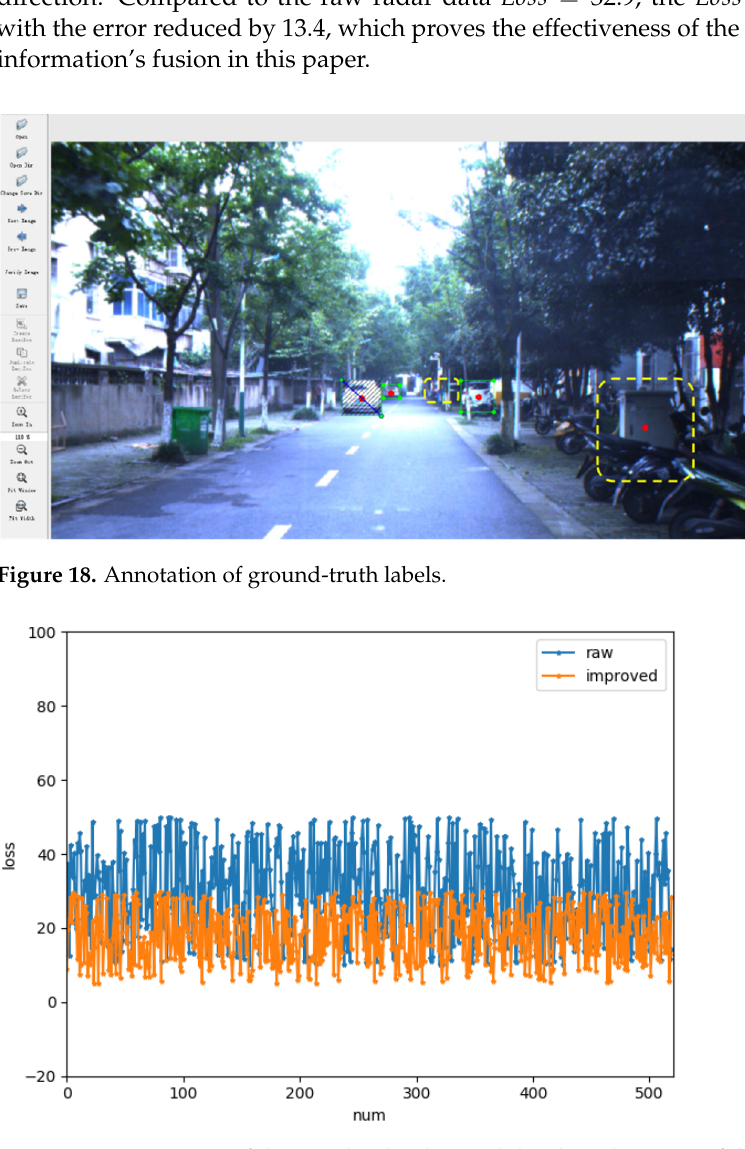
Figure 17. Radar raw data and visualization. ( a ) Initial video of the camera and data of the radar. ( b ) Visual interface of radar detection.